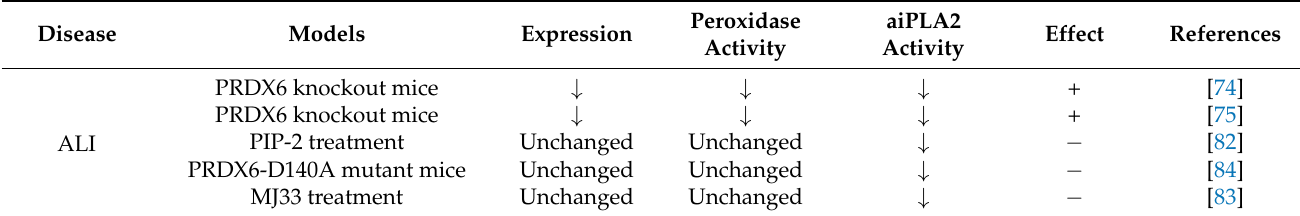
Table 3. PRDX6 expression and activity changes in ALI models.